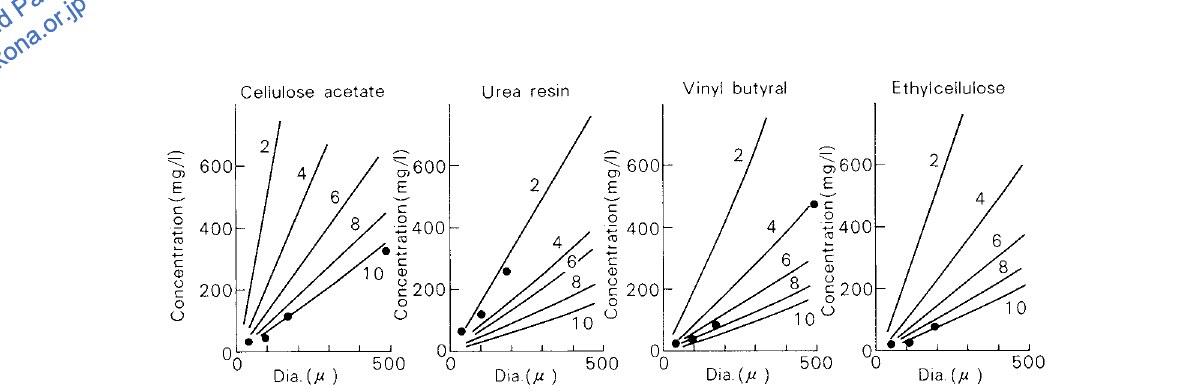
Fig. 8 Comparison of empirical minimum explosible concentration of dust with the present theory